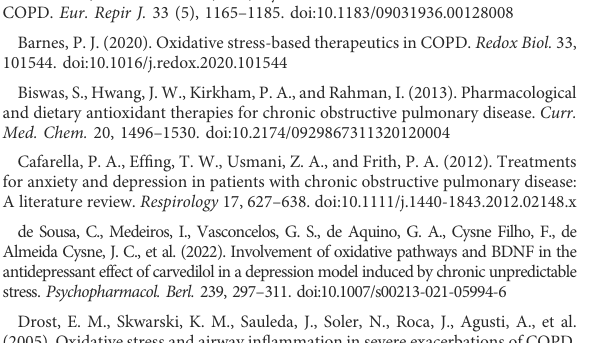
SUPPLEMENTARY FIGURE S1 Effect of NYT on muscle weight in PPE-induced mice. (A) Gastrocnemius muscle. (B) Soleus muscle (Control n = 10, PPE n = 11, 1% NYT n = 8, 3% NYT n = 7). Values are expressed as means ± S.D. p p < 0.05 vs. PPE group by Tukey test. SUPPLEMENTARY FIGURE S2 Locomotor activities under light-dark cycle in PPE-induced mice. Mice